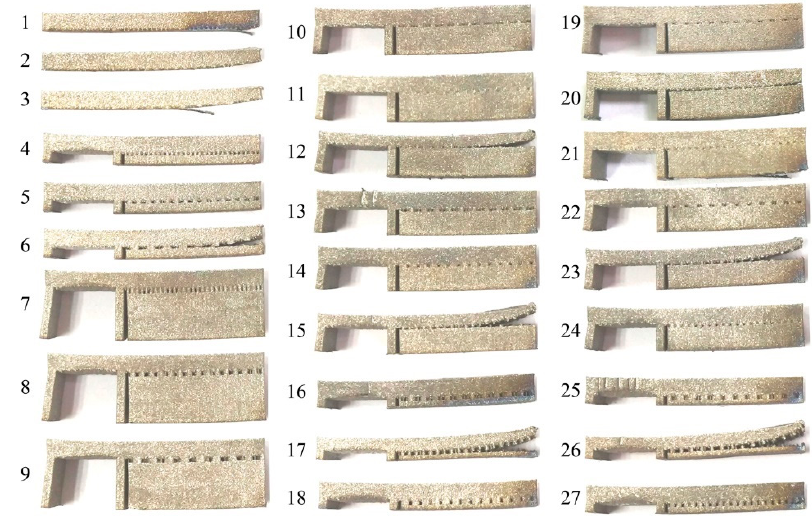
Figure 7. Specimens cut from the build platform by wire electrical discharge machining.